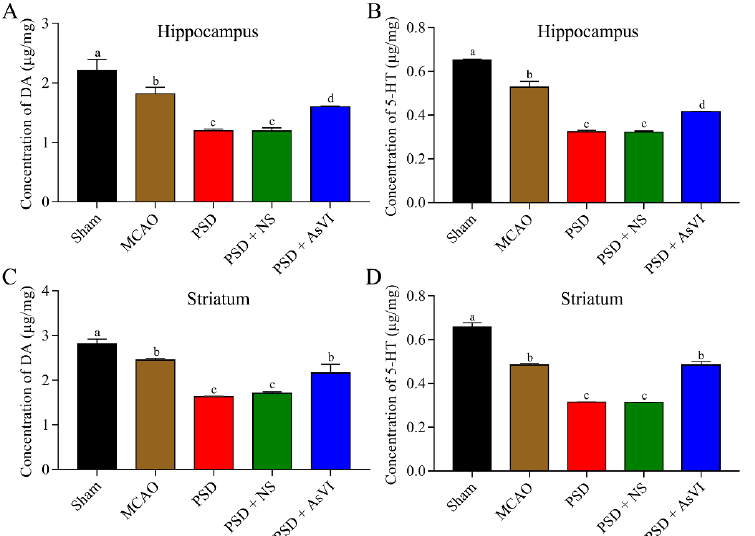
Figure 4. Impacts of AsVI on the brain neurotransmitters in PSD rats. ( A , B ) HPLC analysis was carried out to measure the 5-HT and DA levels in the hippocampus from different cohorts. ( C , D ) HPLC analysis was carried out to measure the 5-HT and DA levels in the striatum from different cohorts. Data are articulated as Mean ± SD. n = 4–6 rats in the cohorts. Distinct letters (a, b, c, d) denote significant differences in various cohorts p < 0.05.